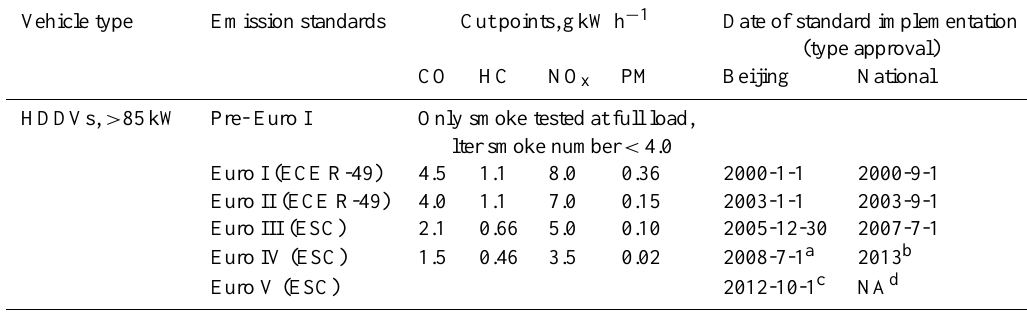
Table 1. Summary of emission standards for new HDDVs adopted in Beijing and